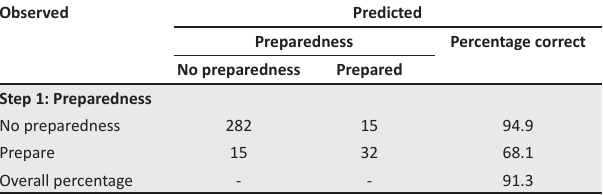
TABLE 3: Binary logistic regression results for classification and prediction of flood preparedness.